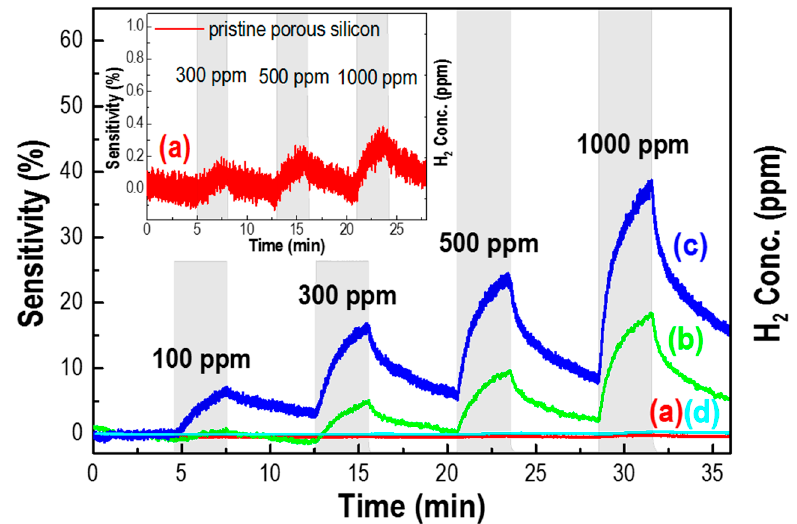
Figure 3. Response of a pristine p-Si wafer (thickness 70 μ m) and G-doped/p-Si sensors with ( a ) 0; ( b ) 0.1; ( c ) 1; and, ( d ) 10 mg/mL graphene concentrations to an air-based H 2 gas operated at room temperature.